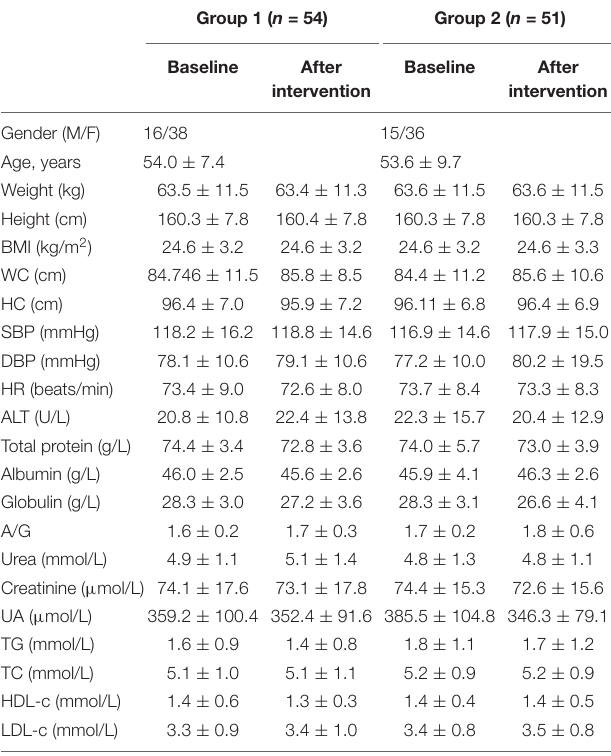
TABLE 1 | Anthropometrics of all participants at baseline and after